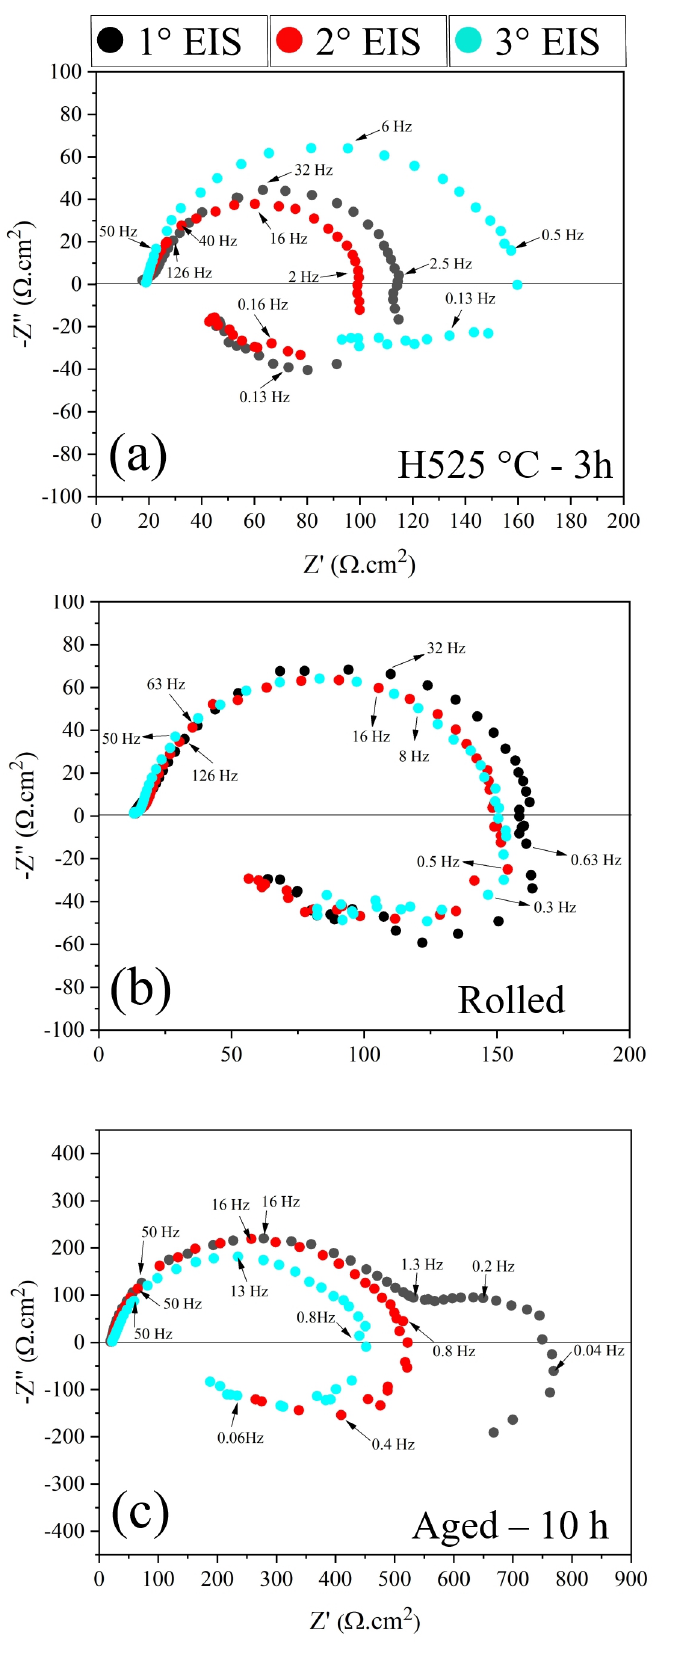
Figure 8. Nyquist curves after 30 min (1°EIS), 50 min (2°EIS) and 70 min (3°EIS) of immersion times ( a ) H525 ◦ C-3 h, ( b ) rolled and ( c ) aged-10 h specimens in 0.9 wt.% NaCl aqueous solution at 37.0 ± 0.5 ◦